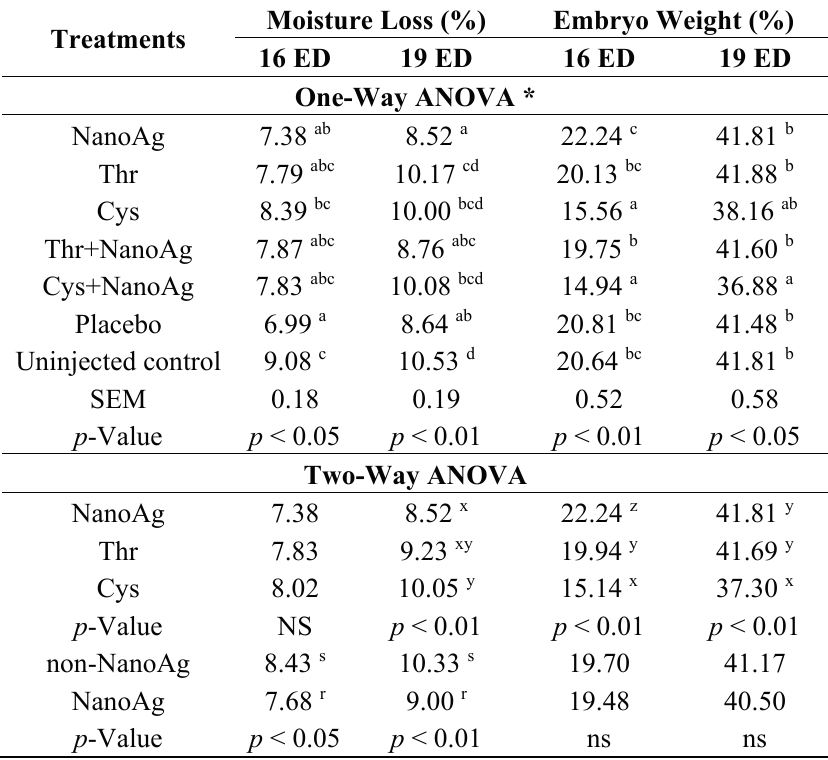
Table 1. Moisture loss and embryo weight in eggs injected with nanoparticles of silver (NanoAg), threonine (Thr), cysteine (Cys) and their combinations. Measured at 16 and 19 day of embryogenesis